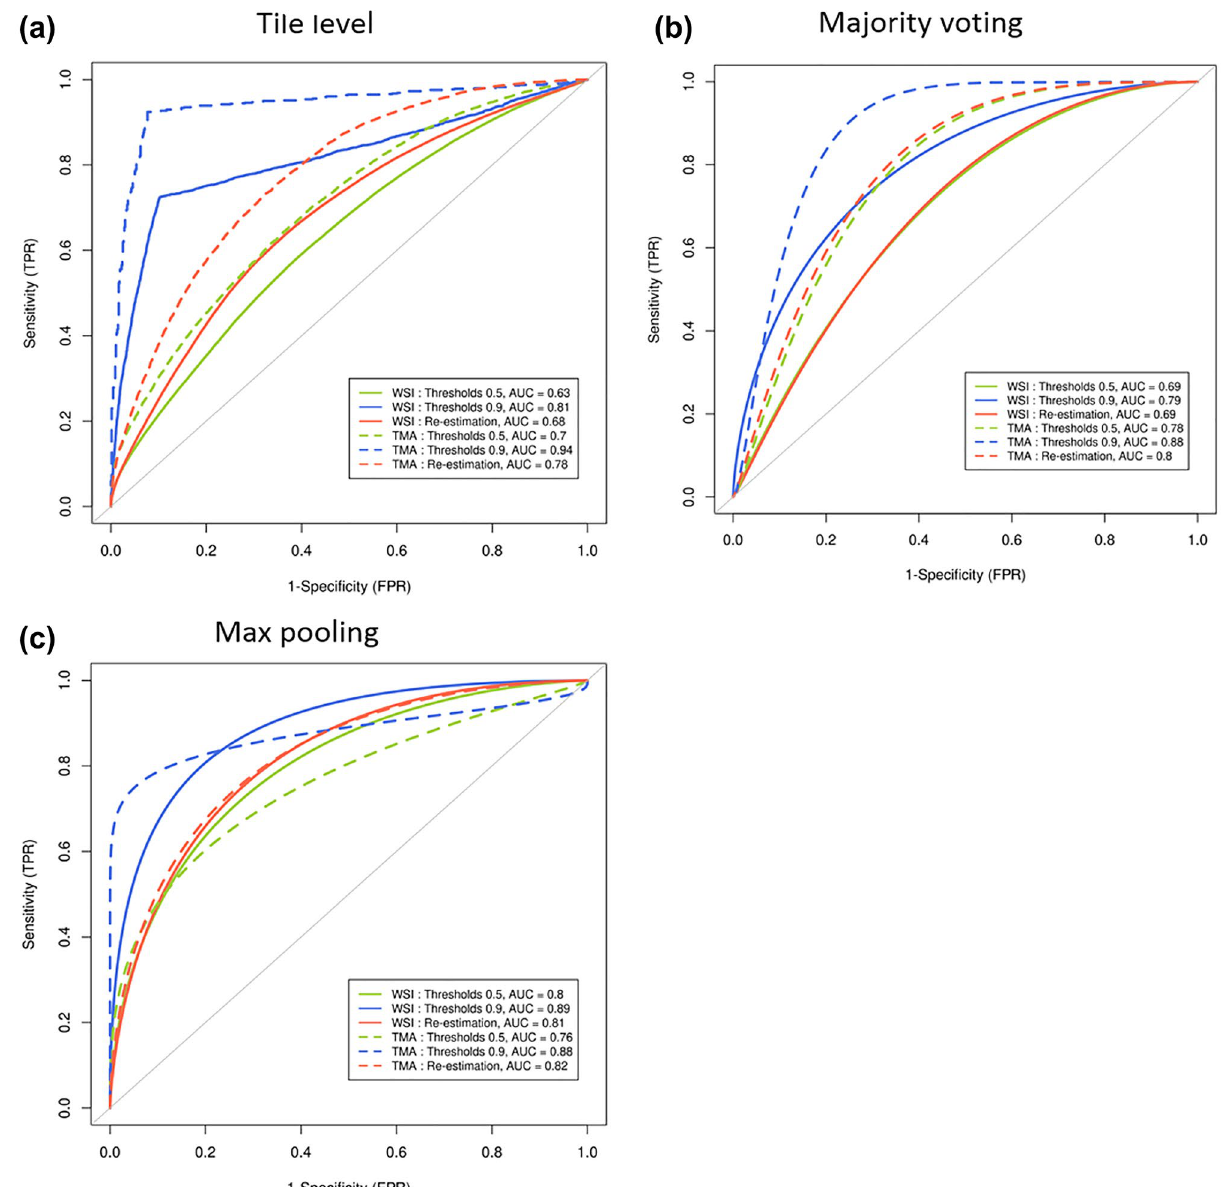
blue and red lines correspond respectively to threshold equal to 0.5, threshold equal to 0.9 and re-estimation using filter kernel. Solid and dashed lines respectively correspond to the prediction of tiles from whole slides and